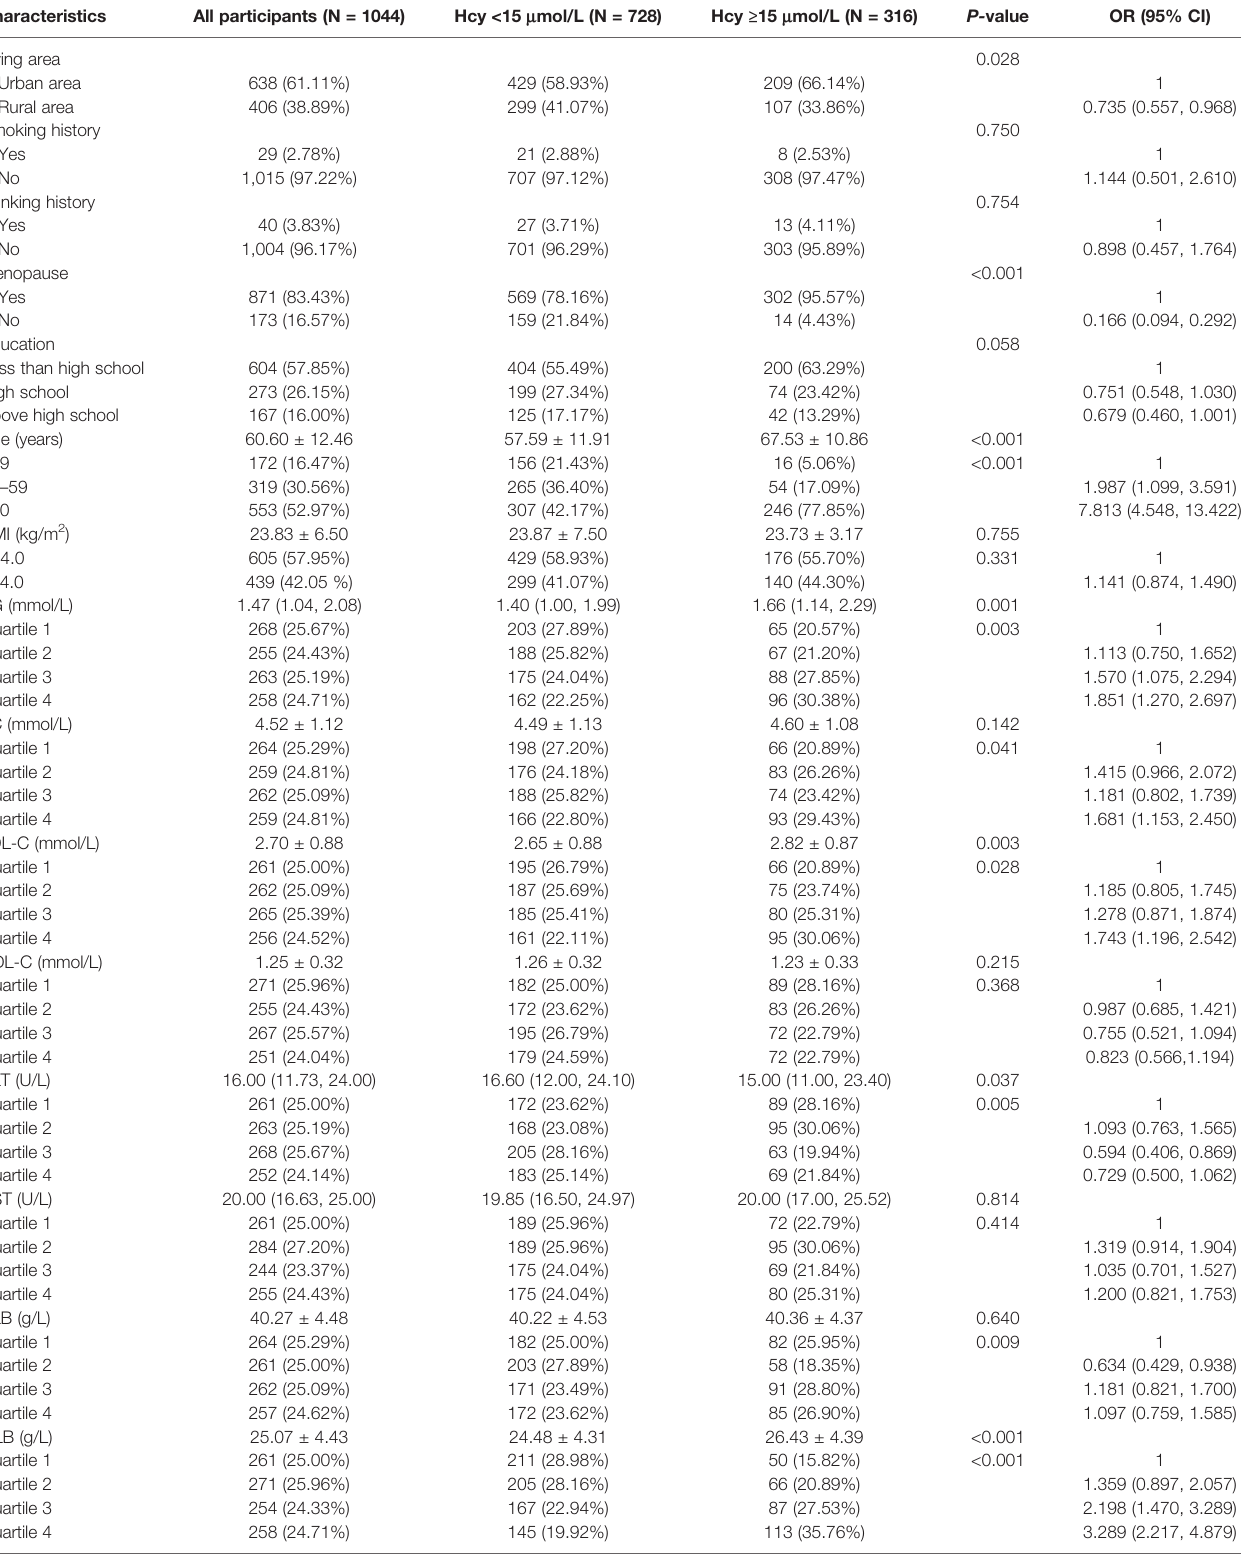
TABLE 1 | Differences in general demographic data and clinical indicators of the study population.